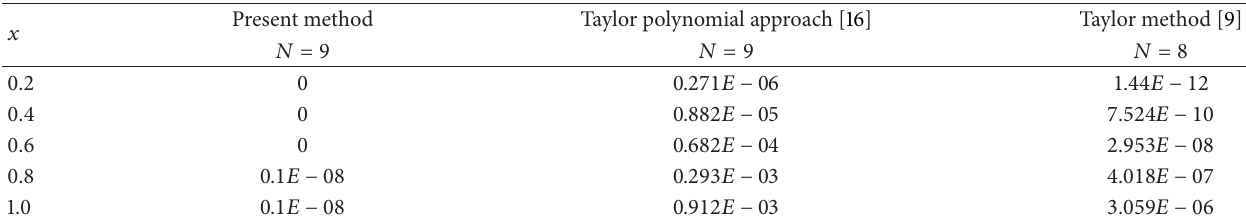
Table 2: Comparison of the absolute errors of different approximation techniques to Example 2.